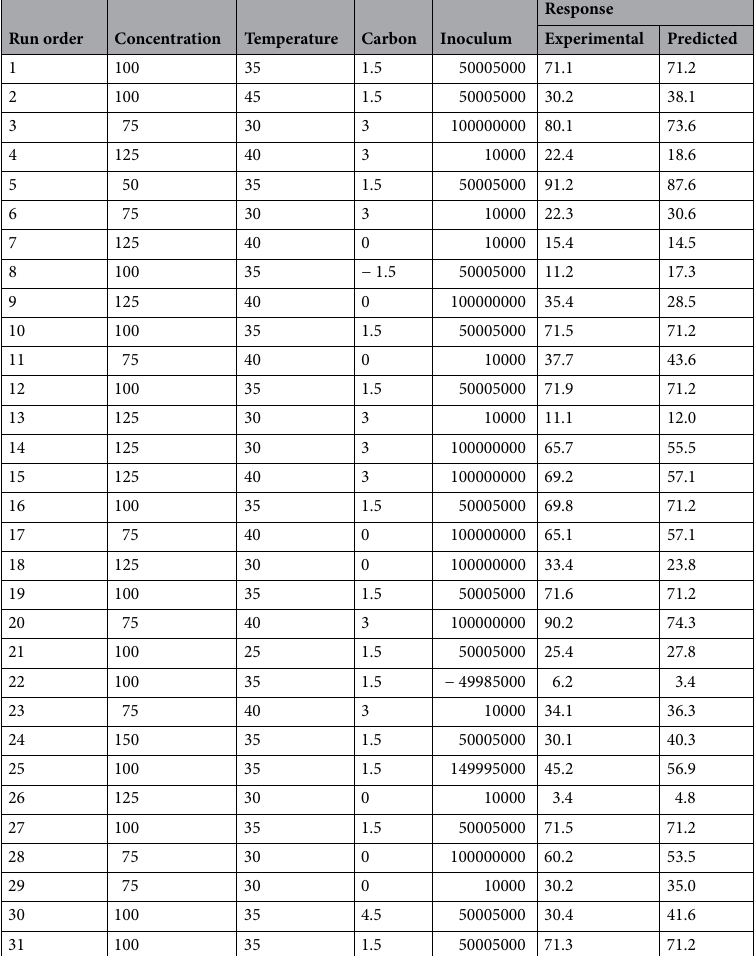
Table 4. Experimental design and results of central composite design